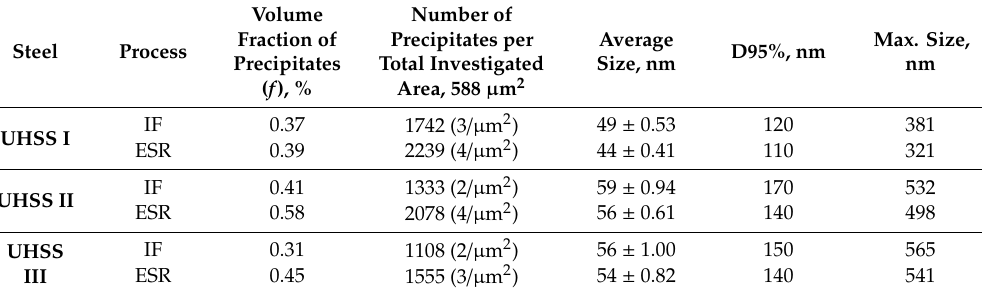
Figure 9. INLENS-SEM micrographs for precipitates of UHSS I, II and III without ESR ( a , c , e ) and with ESR ( b , d , f ). Table 4. Characteristics of precipitates in UHSS I, II and III without and with ESR.